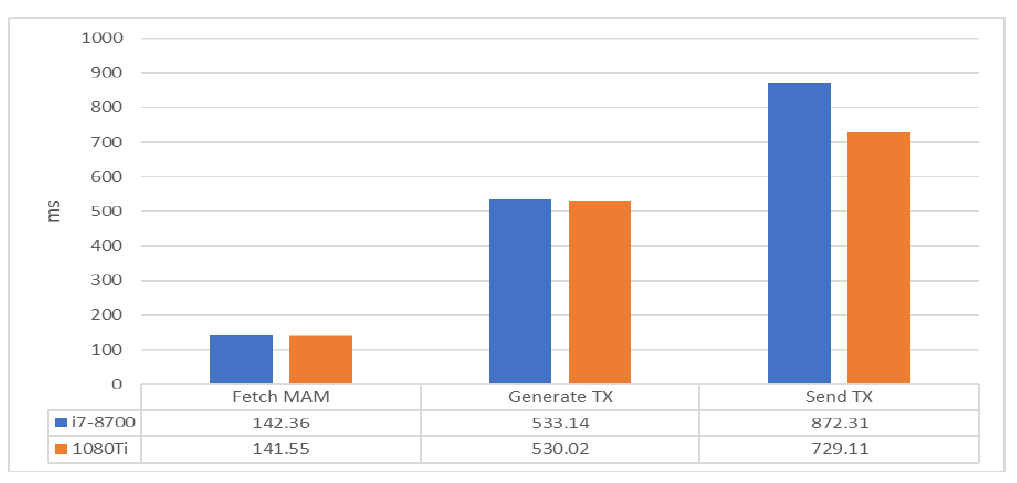
Figure 13. Registration cost.